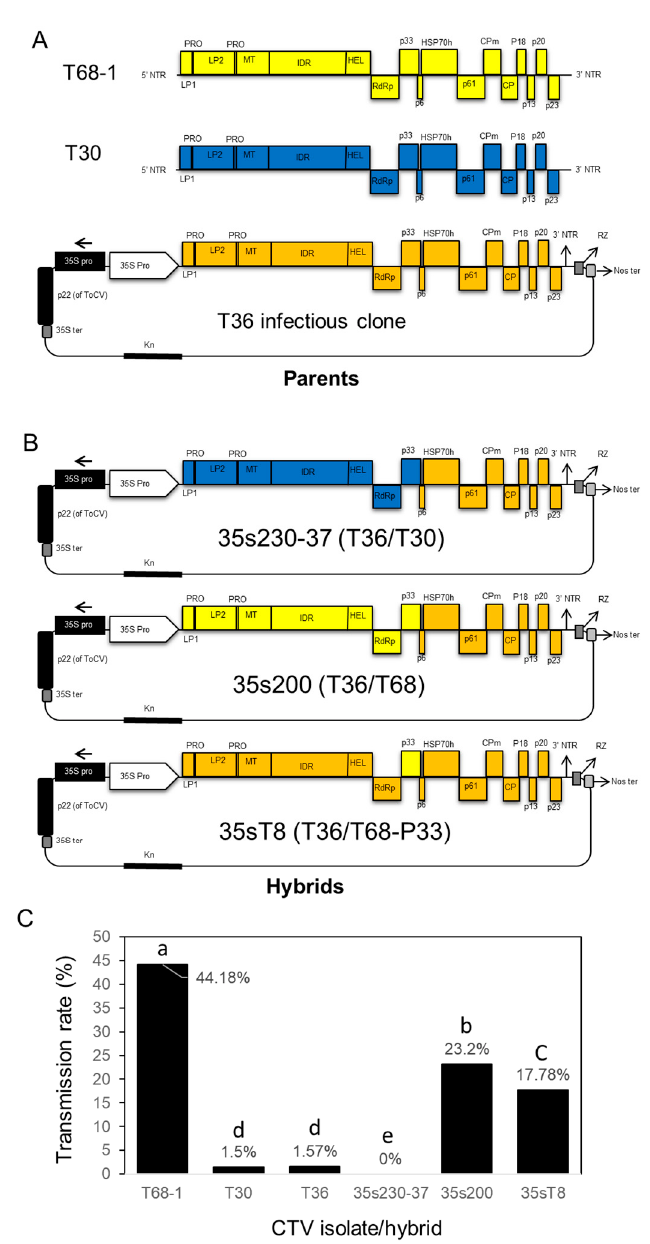
Figure 4. Aphid transmission of CTV strains and constructed hybrids. ( A ) Schematic representation of the genome of the parent CTV isolates (T68-1, T30, and T36 infectious clone) used to construct the hybrids. ( B ) Schematic representation of the infectious hybrid clones (35s230-37, 35s200, and 35sT8) showing the replaced genes. ( C ) Transmission rates of the parent isolates and the constructed infectious hybrids by A. citricidus. Genes from T36 are colored in orange, genes from T68-1 are colored in blue, and genes from T30 are colored in yellow. Treatments with different letters on bars indicate statistically different transmission rates ( p < 0.05).